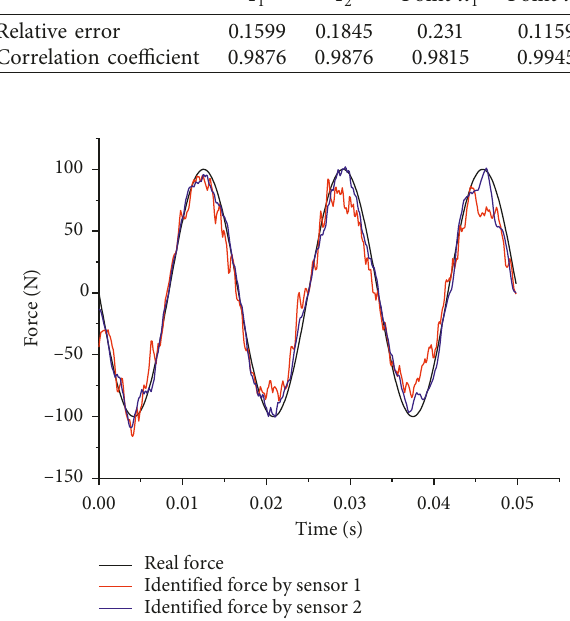
Figure 7: The reconstruction of the load F